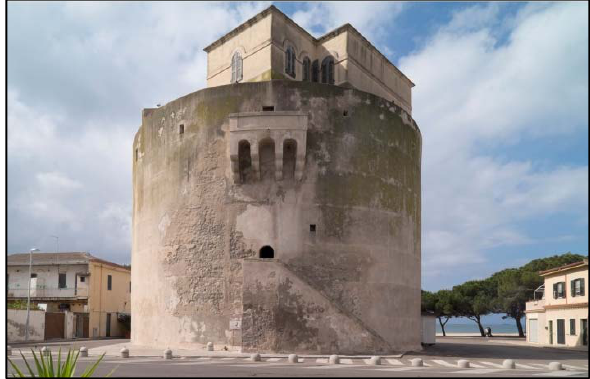
Figure 3. The Gran Torre of